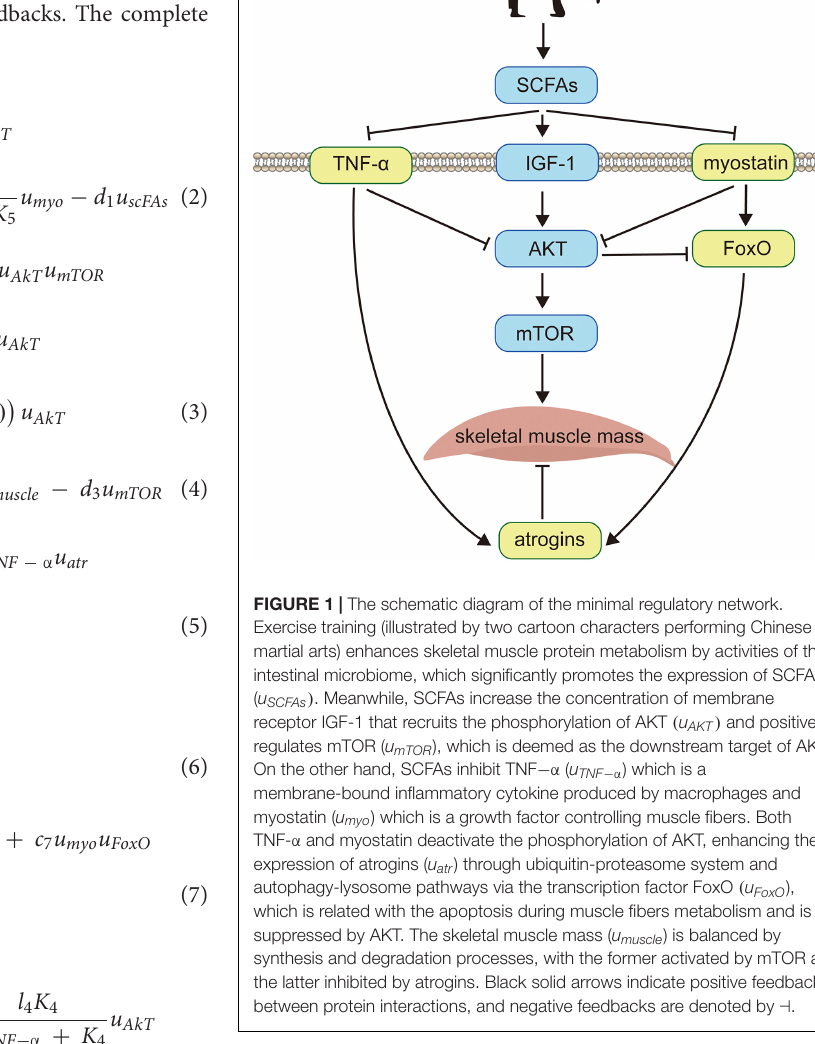
productivity rate of SCFAs fecal metabolites is maximized with rising exercise intensity (Lamoureux et al., 2017; Liu et